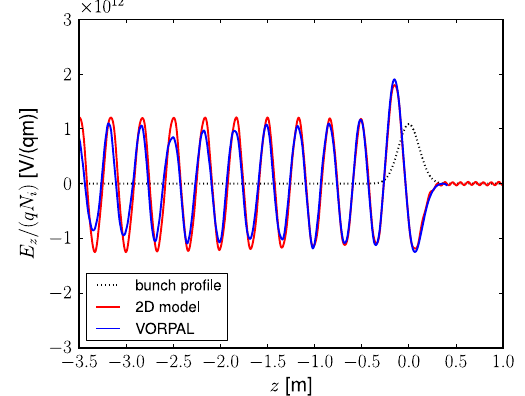
scale.FIG. 7. Longitudinal electric field obtained from the 2D ES and the 3D EM simulations for n e ¼ 10 16 m (cid:2) 3